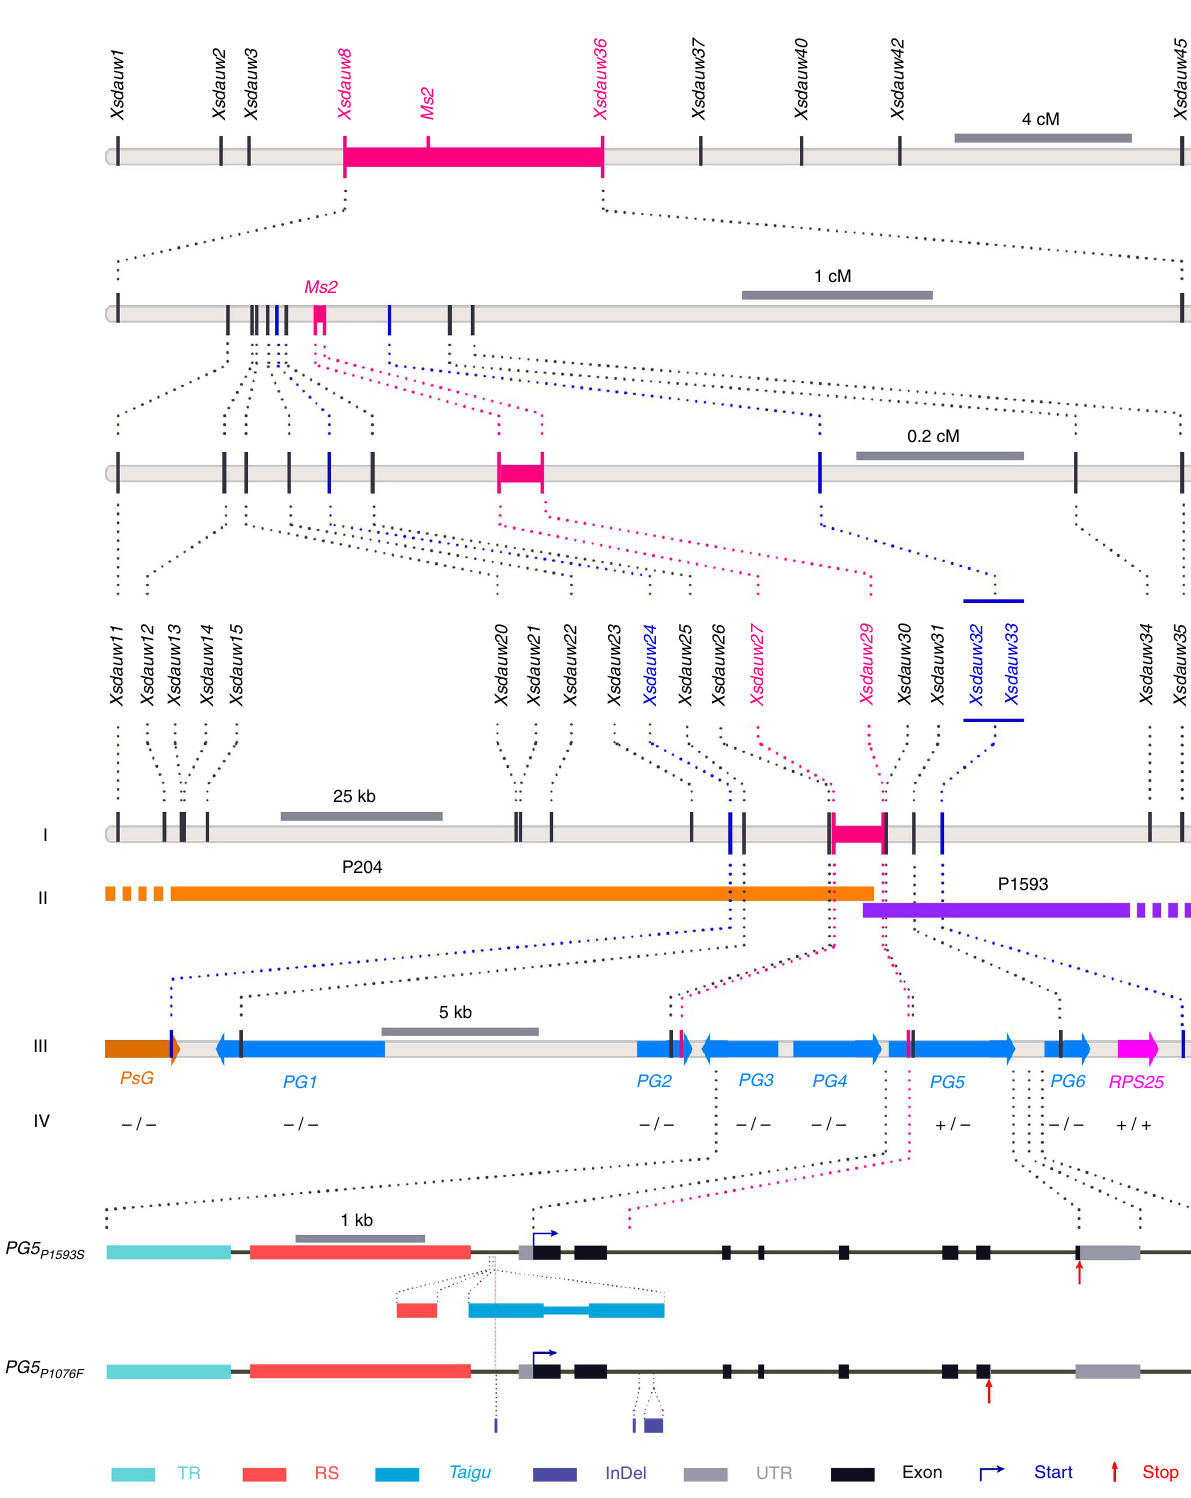
Figure 2 | Map-based cloning of Ms2 . ( a , b ) Maps based on popA. ( c ) Physical maps of the Ms2 region: (I) markers; (II) Ms2 -associated BAC clones; (III) gene, pseudogene ( PsG ) or potential genes ( PG ) in the Xsdauw24 - Xsdauw32 interval; (IV) mRNA detected ( þ ) or not ( (cid:2) ) in S2-stage anthers of LM15 RMs2 / LM15 ( PG5 additionally tested in Ms2 -isogenic lines of CS RMs2 /CS and XY6 Ms2 /XY6; RT-PCR data is provided in Supplementary Fig. 18). ( d ) Genomic structure of PG5 P1593S and PG5 P1076F . Primers for RT-PCR were described in the Supplementary Data 2. InDel, insertion or deletion; RS, repetitive sequence; Start and Stop, respective codons; Taigu , a class 1 LTR retrotransposon; TR, tandem repeat; UTR,